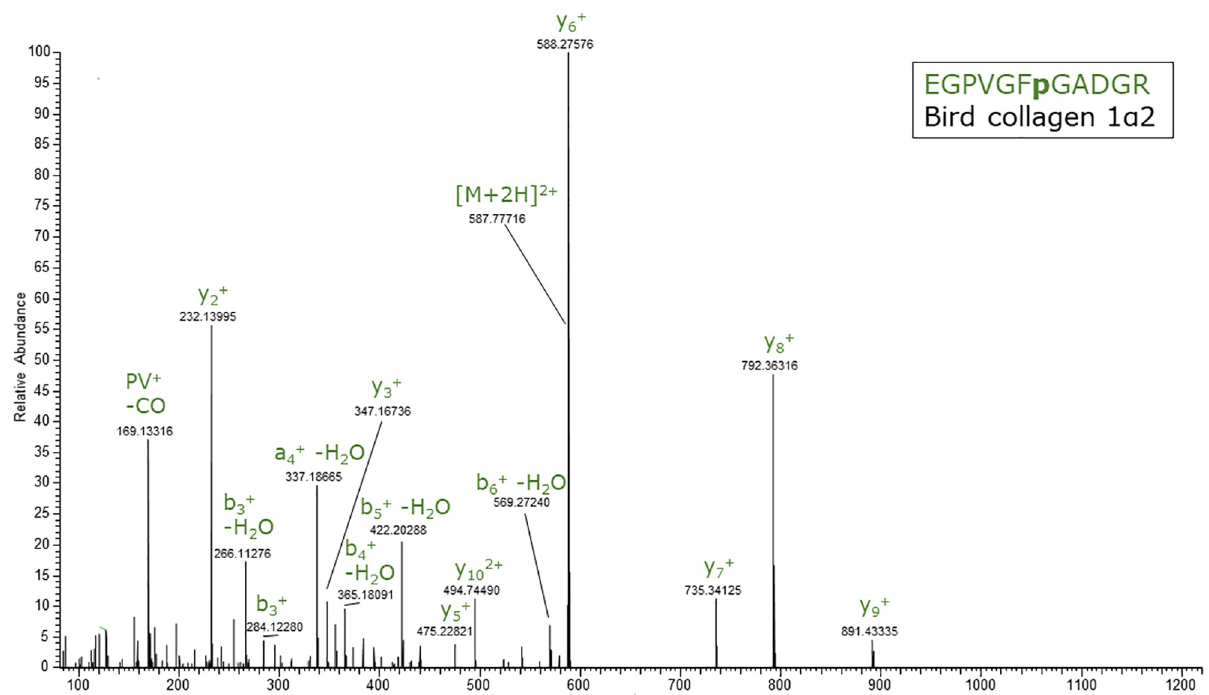
Fig 6. MS/MS spectrum of EGPVGFpGADGR. MS/MS spectrum of the tryptic collagen 1 α 2 peptide EGPVGF p GADGR (precursor m/z 587.78), which is generic for birds regarding the investigated bird species, but also occurs in crocodile and turtle species. The spectrum was obtained from chicken broth (brand